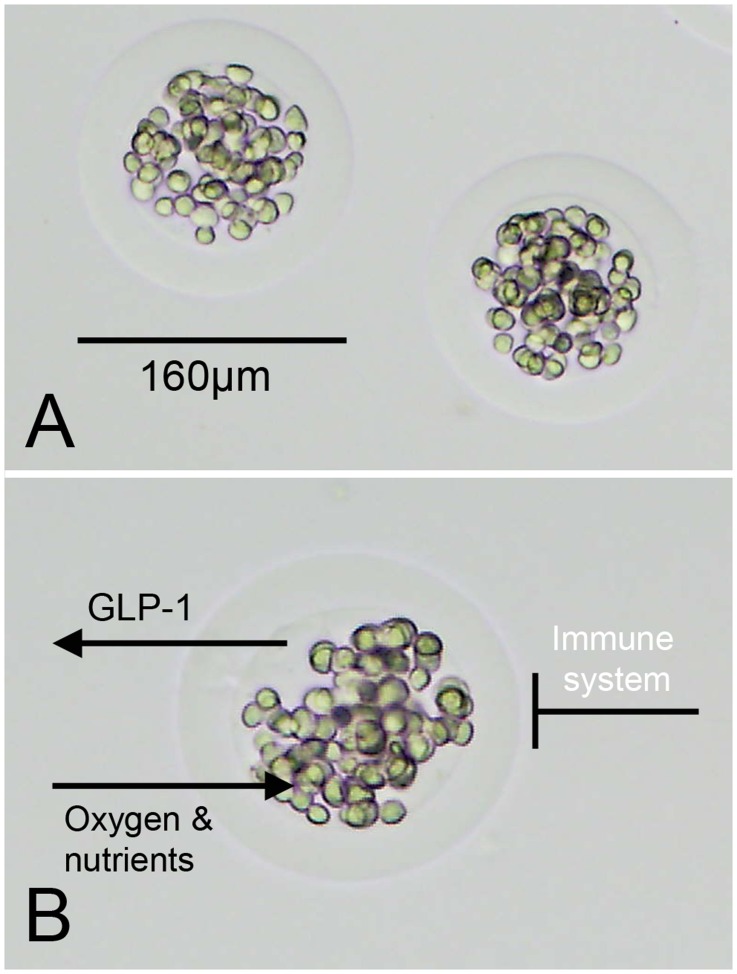
Alginate encapsulated GLP-1 producing mesenchymal cells.(A) Encapsulation with alginate leads to GLP-1 MSC capsules with a mean diameter of 161 µm. (B) GLP-1, oxygen and nutrients are able to pass the alginate barrier, but the cells are protected against the hosts’ immune system.